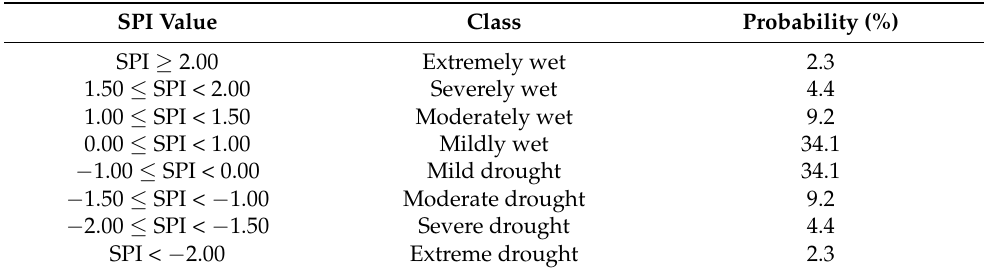
Table 1. Climate classification according to the SPI values.